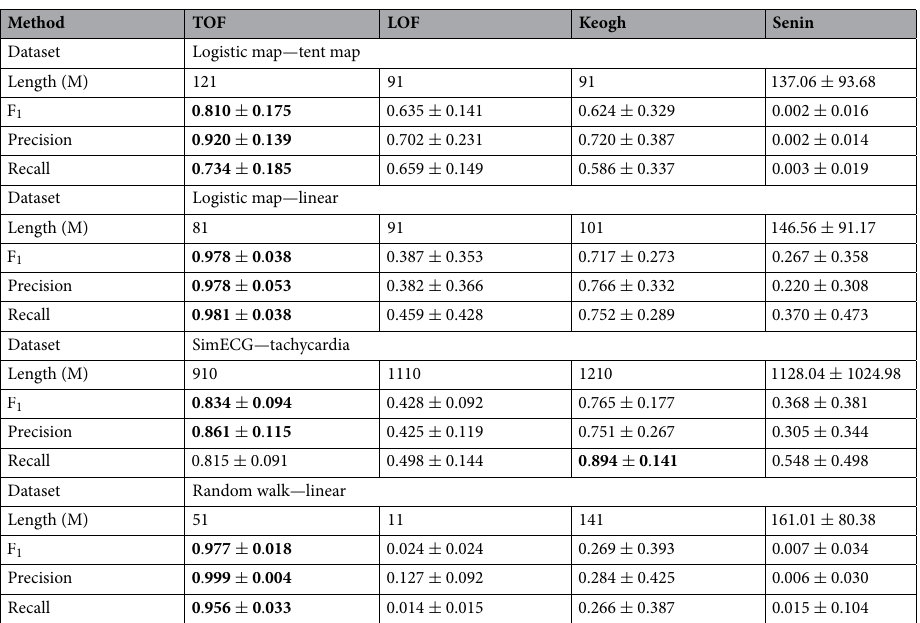
Table 2. Performance evaluation by F 1 , precision and recall scores on simulations. The optimal expected anomaly length parameter (M) in time steps, mean scores, and their standard deviations are shown for all methods and datasets; the highest scores are highlighted in bold. In case of TOF, k = 4 neighbour number is used, while for LOF, the k resulted the best ROC AUC were used from Table 1: k = 42 for logmap-tent map, k = 199 for logmap-linear, k = 129 for ECG tachycardia and k = 1 for random walk-linear datasets. TOF resulted in the highest F 1 scores and highest precision for all datasets and the highest recall in three of the four cases but the simulated ECG tachycardia, where Keogh’s brute force discord detection algorithm reached a slightly higher recall score. The only comparable performance was reached by Keogh’s discord detection algorithm on ECG tachycardia in terms of F 1 score while LOF produced reasonable results on logmap-tent map anomaly series. Although Senin’s discord detection algorithm resulted in reasonable mean estimations for the lengths of the anomalies, its detection performance was worse than the other three